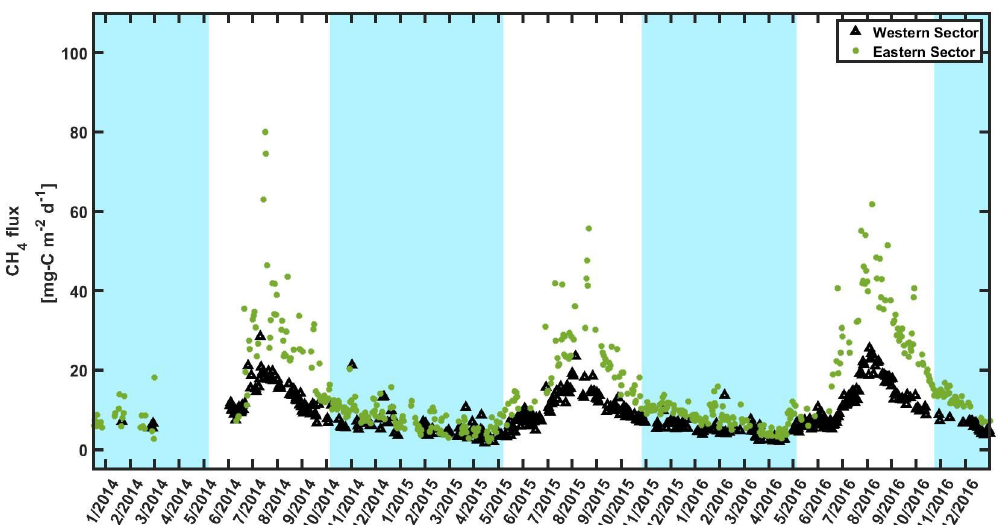
Figure 5. Time series for non-gap-filled CH 4 daily averaged fluxes for the western sector (green triangles) and the eastern sector (black dots), where the shaded light blue area is the frozen period when peat temperature at 10cm was below 0 ◦ C (see Sect. 2.8 for a detailed description).